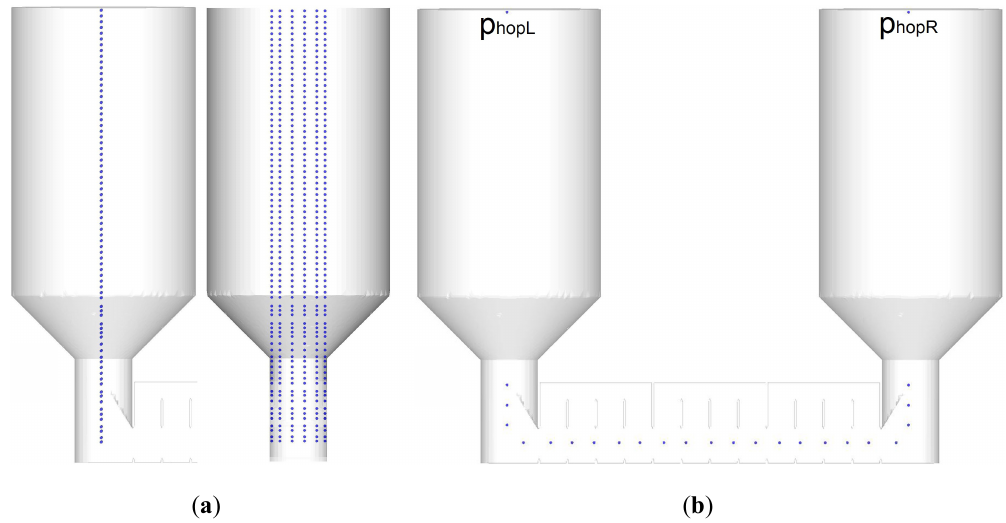
Figure 3. ( a ) Four-hundred-and-fifty-six data points per hopper for logging of the porosity ψ and ( b ) 25 data points overall for the pressure p , as set up in Barracuda, [20].